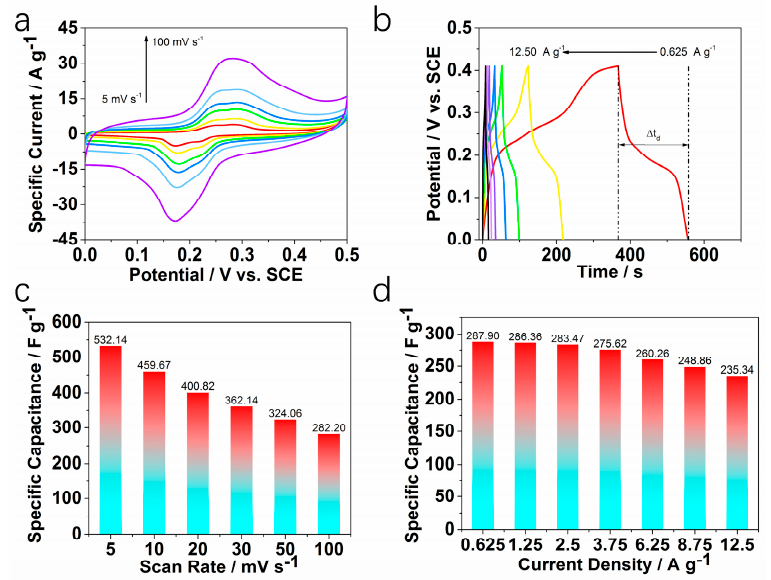
Figure 6. ( a ) CV (Cyclic voltammetry) curves at scan rates of 5–100 mV · s − 1 of as-prepared MnPO 4 · H 2 O nanowire/GO material in a three-electrode system; ( b ) GCD (galvanostatic charge–discharge) curves of MnPO 4 · H 2 O nanowire/GO material at current densities of 0.625–12.5 A · g − 1 ; ( c ) specific capacitances derived from the CV curves by Equation (1); and ( d ) specific capacitances calculated from the GCD curves by Equation (2) at various charge–discharge